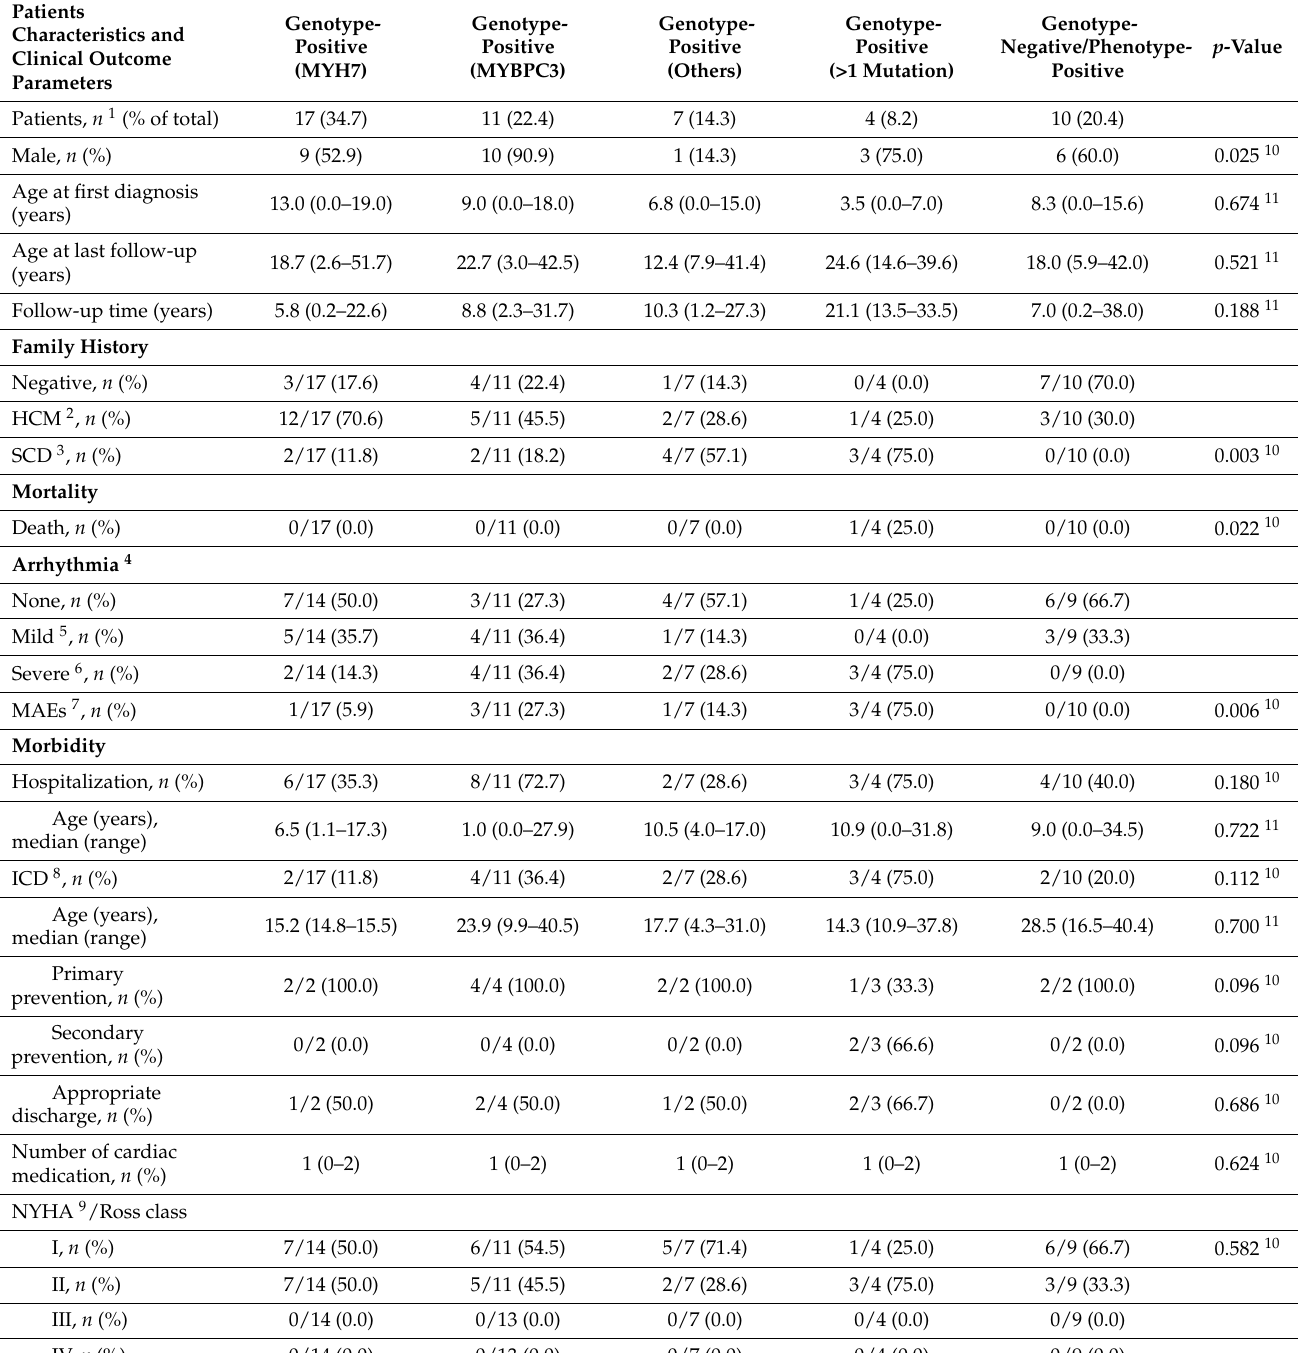
Table 1. Patient characteristics and clinical outcome